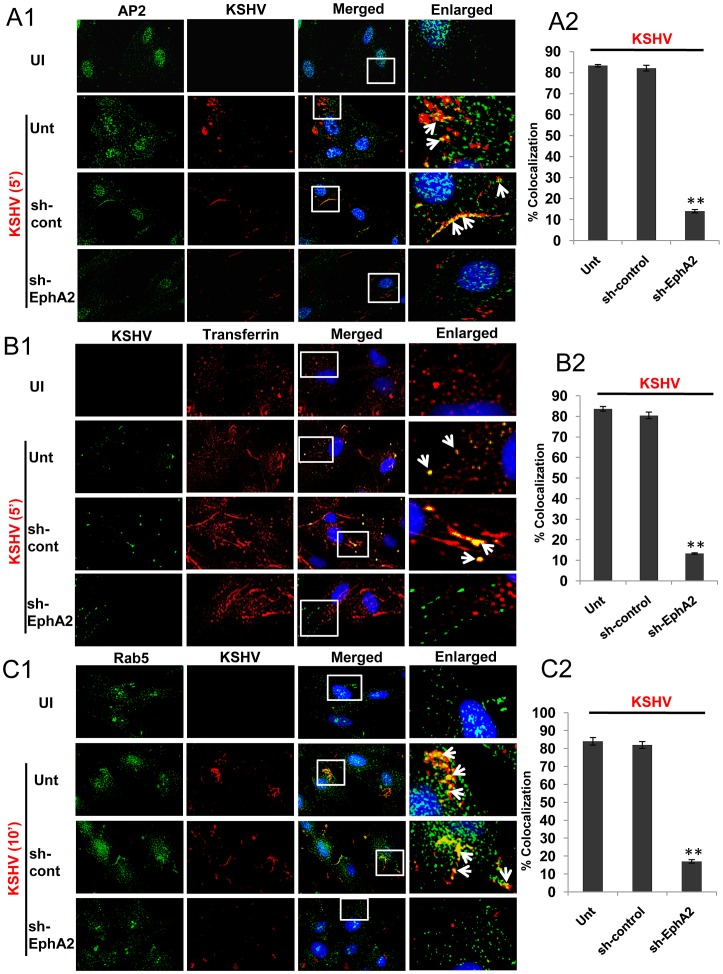
EphA2 knockdown has a negative effect on KSHV trafficking in the early endosome due to defective endocytosis.(A) Control sh-RNA or EphA2-sh-RNA-transduced or untransduced HFF cells were serum starved and either mock infected (UI) or infected with KSHV (30 DNA copies/cell) for 5 min at 37°C and were processed for immunofluorescence assay using clathrin adaptor AP2 and mouse-gpK8.1A antibodies for 2 h at room temperature followed by staining with anti-rabbit Alexa fluor 488 or mouse Alexa fluor 594. The enlarged pictures represent boxed regions within the merged panels and the white arrows represent colocalization of the indicated molecules. Representative 2D convoluted images are shown (A1). Quantification of KSHV particles colocalized with AP2 molecules was performed by counting three different fields having atleast 10 cells each and error bars represent mean ± SD, ** represents p<0.01 (A2). (B) Control or EphA2 sh-RNA-transduced HFF cells either mock infected (UI) or infected with medium containing Alexa 594-transferrin along with KSHV (30 DNA copies/cell) for 5 min at 37°C were subjected to immunofluorescence assay using rabbit anti-gB antibody for 2 h at room temperature followed by staining with anti-rabbit Alexa fluor 488. Representative 2D convoluted images are shown (B1). The enlarged pictures represent boxed regions within the merged panels and the white arrows represent colocalization of the indicated molecules. Quantification of KSHV particles colocalized with Transferrin molecules was performed by counting three fields with atleast 10 cells each and error bars represent mean ± SD, ** represents p<0.01 (B2). (C) (C1) Serum starved control sh-RNA or EphA2 sh-RNA transduced HFF cells, either mock infected or infected with KSHV for 10 min at 37°C, were washed and processed for immunofluorescence using rabbit anti Rab5 and mouse anti-gpK8.1A antibodies for 2 h at room temperature followed by staining with anti-rabbit Alexa fluor 488 or mouse Alexa fluor 594. Representative 2D convoluted images are shown. The white boxes within the merged panels are shown as enlarged pictures and the white arrows represent colocalization of the indicated molecules. (C2) Quantitation of KSHV accumulated in Rab5 positive endosomes was performed by counting three different fields having at least 10 cells each and error bars represent mean ± SD, ** represents p<0.01.